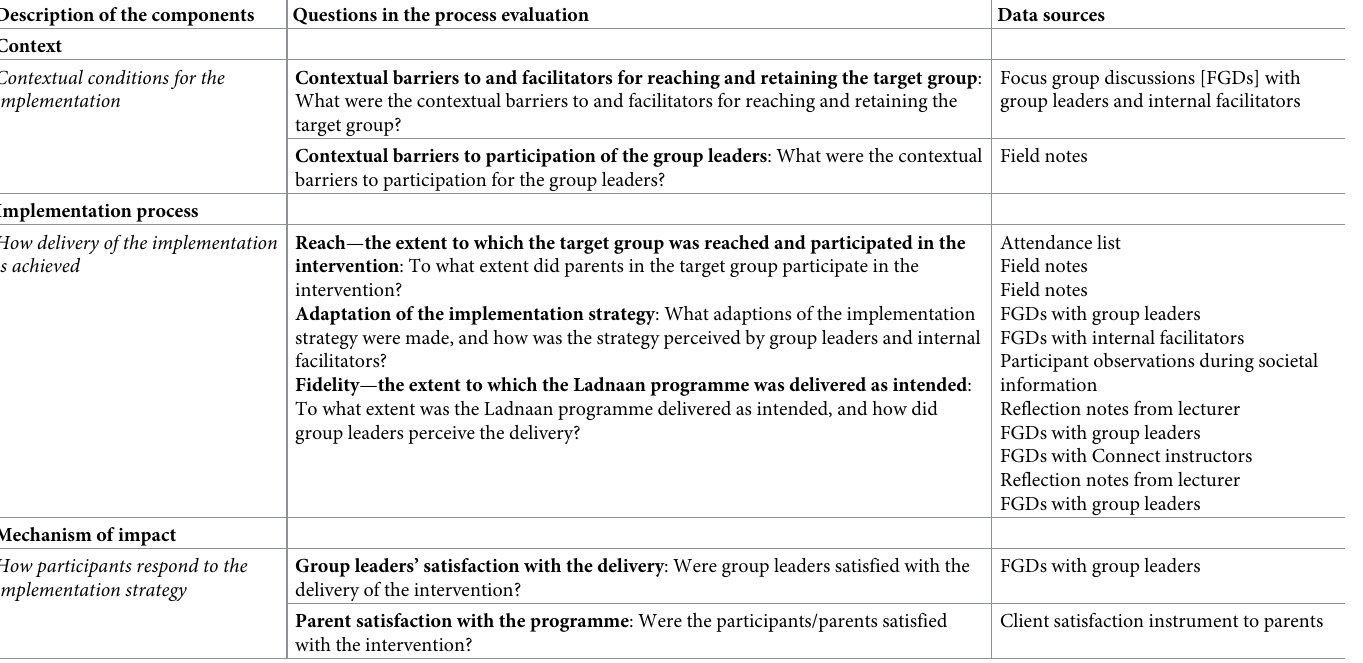
Table 1. Blueprint of key components in the process